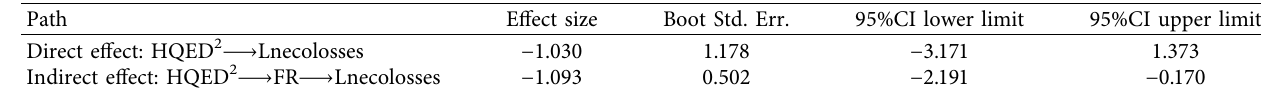
Table 6: Bootstrap test results of mediating effect.